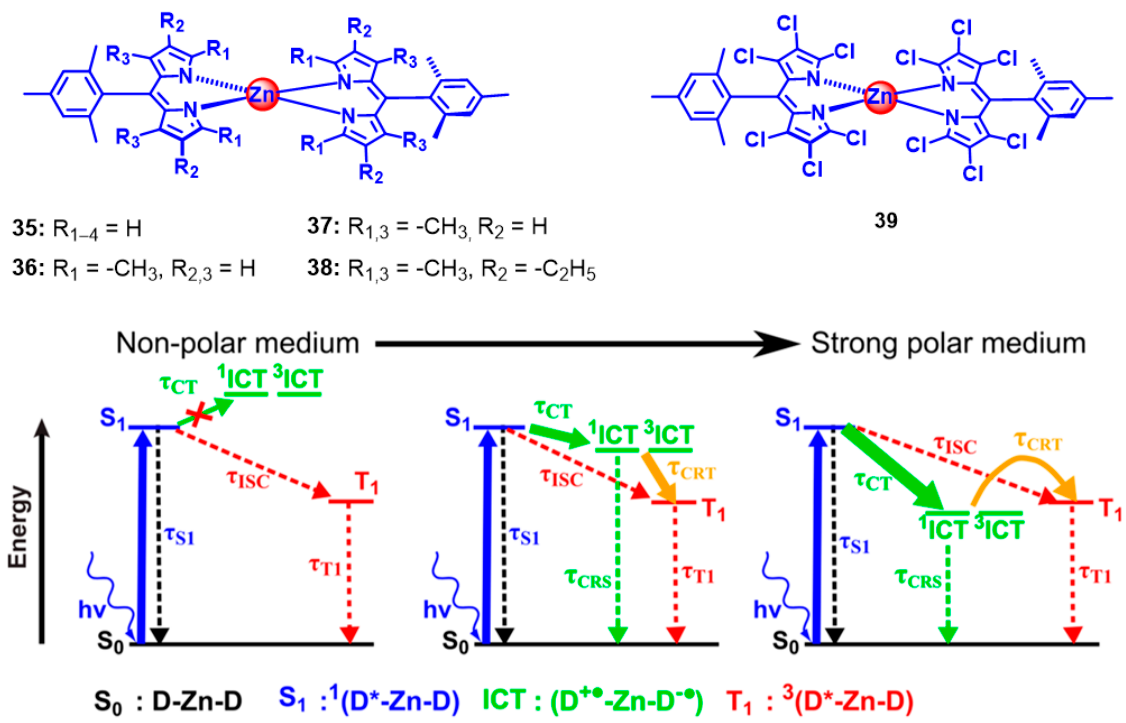
Figure 12. Zn dipyrrin and chlorodipyrrin complexes showing SBCT and ISC. The solvent polarity- dependent photophysical processes of the Zn chlorodipyrrin complex are shown at the bottom. * indicates the excited state. Reproduced with permission from reference [67], copyright 2018, American Chemical Society.